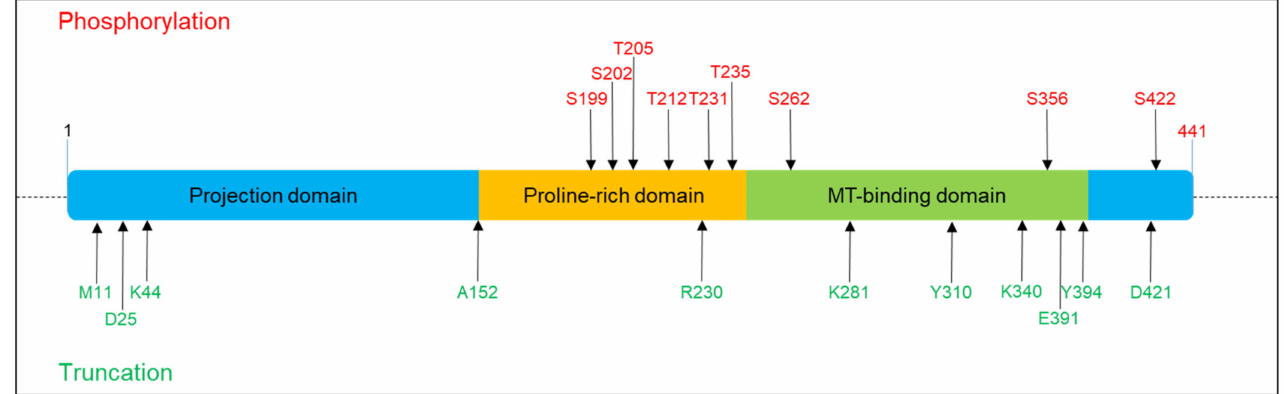
Figure 1. Phosphorylation and truncation sites on Tau protein described in this review. The scheme refers to 2N4R Tau (441 aa). Red colour denotes the phosphorylation sites, and green colour denotes the truncation